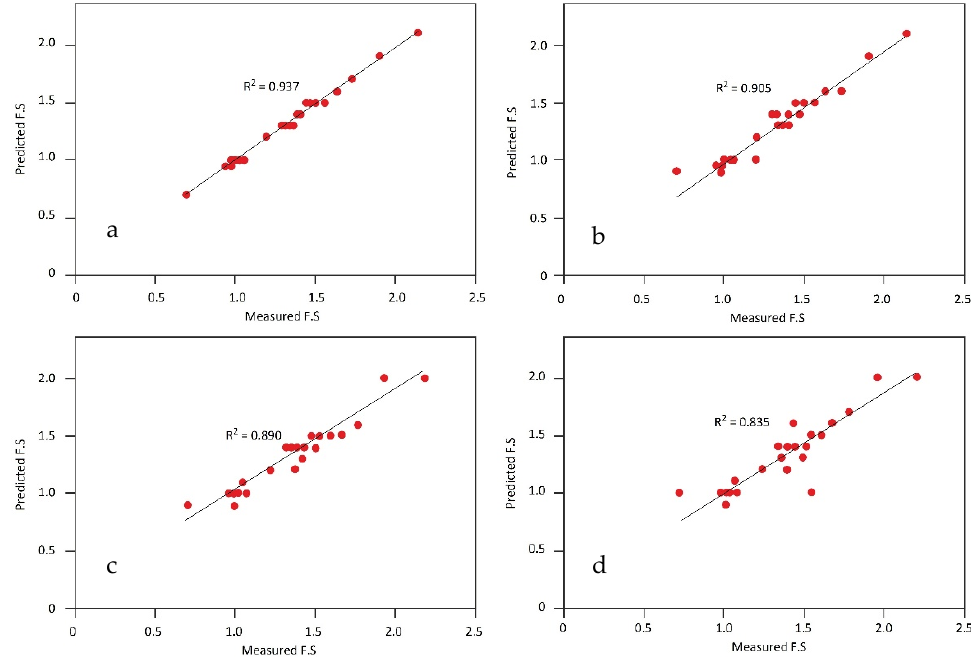
Figure 4. Measured and predicted correlation for testing results: ( a ) MLP, ( b ) SVM, ( c ) DT, ( d ) RF.